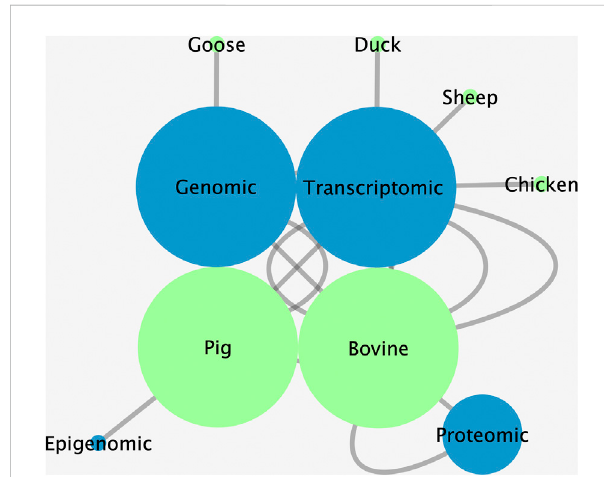
FIGURE 1 Enrichment analysis highlighting the multi-omics approaches (blue nodes) used and the most livestock species (green nodes) studied in the Research Topic. The size of the nodes corresponds to the Cytoscape network enrichment analysis, as the bigger the nodes, the more used and/or studied were the corresponding